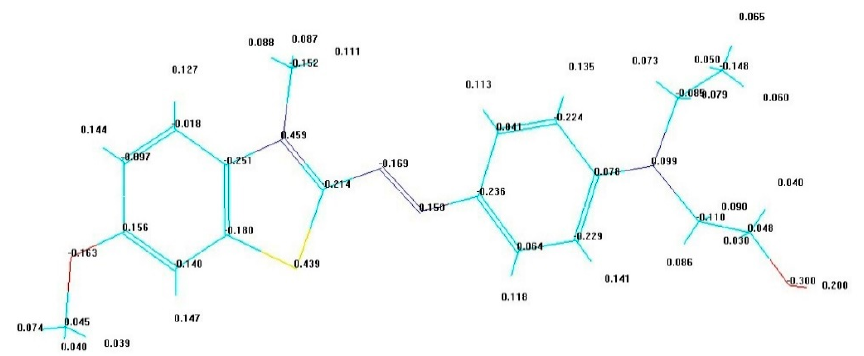
Figure 10. Mulliken atomic charges distribution (e − ) of Basic Blue-41 molecule, as deduced from their optimized PM3 molecular geometries.